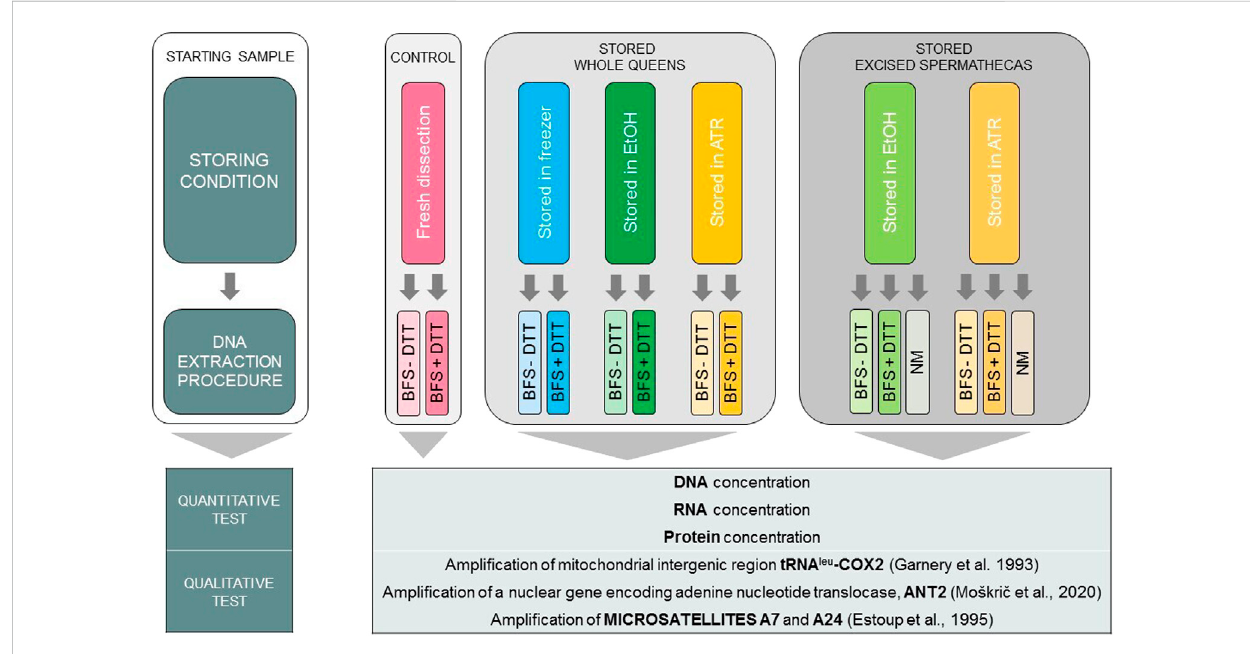
FIGURE 1 SummarizedexperimentaldesignofsixdifferentstoringconditionscoupledwiththreealternativeDNAextractionmethods.DNAextractswerethen tested quantitatively and qualitatively. Abbreviations: ATR, Allprotect Tissue Reagent; EtOH, absolute ethanol; DAF, dissected after freezing; FD, freshly dissected;BFS,QIAampprotocol “ IsolationofTotalDNAfromBodyFluidStains ” ;+DTT,withdithiothreitol; − DTT,withoutdithiothreitol;NM,NucleoMag Tissue Kit ’ s